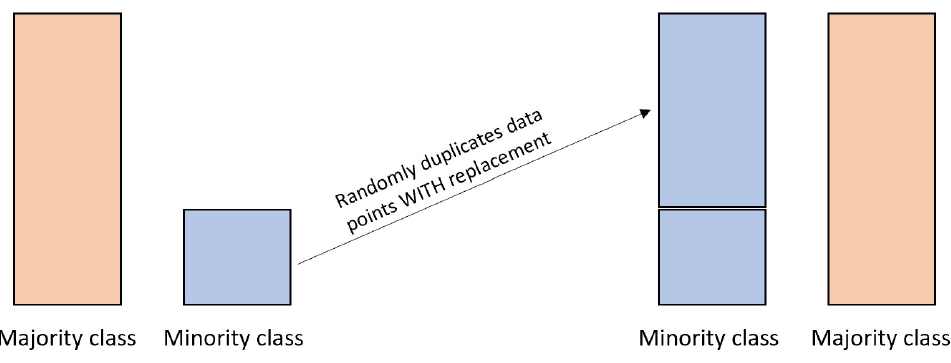
Figure 1. Random oversampling process.